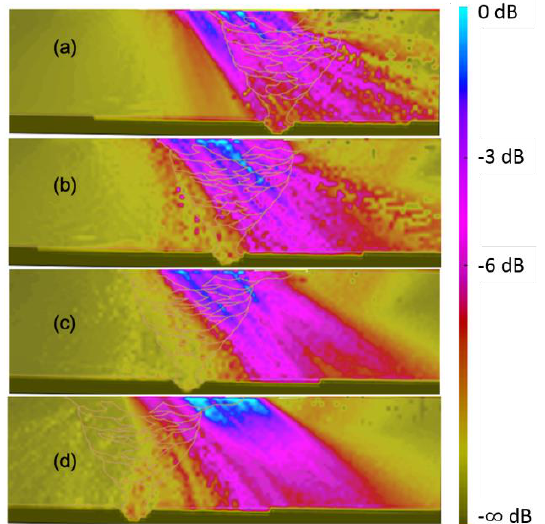
Figure 7. Longitudinal wave inspection. Scanning angle of 45 ◦ with 16 elements. Indexes: ( a ) 10 mm, ( b ) 23 mm, ( c ) 35 mm and ( d ) 48 mm.